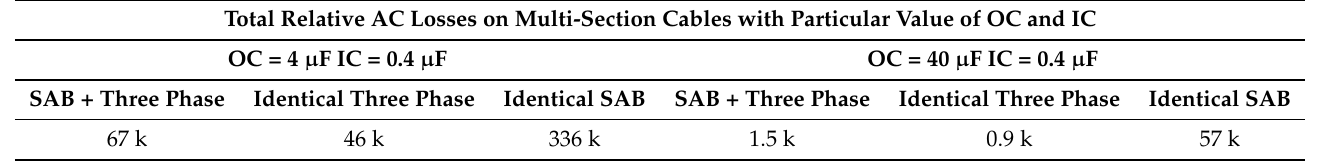
Table 2. Total relative AC losses on multi-section cables with particular values of OC and IC. Total Relative AC Losses on Multi-Section Cables with Particular Value of OC and IC